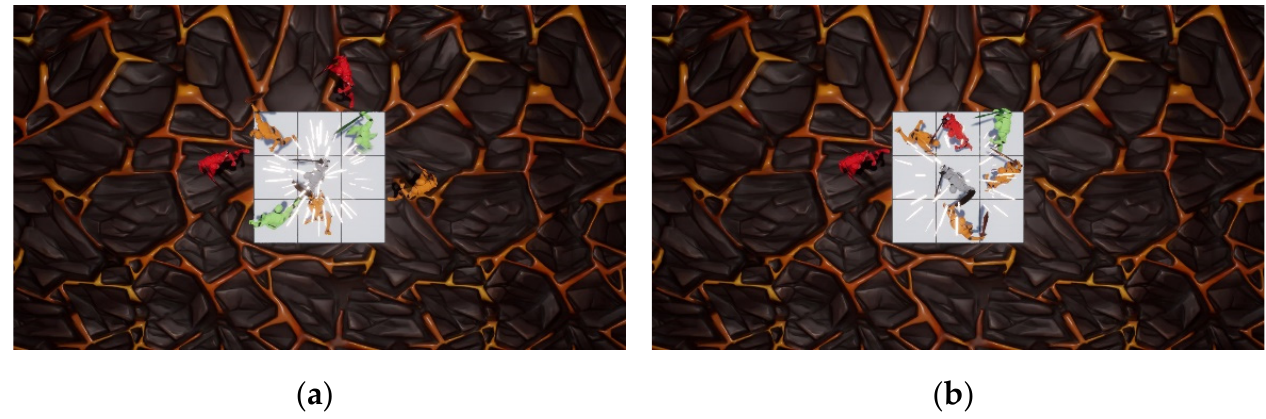
Figure 7. Attack mechanism tests of BAI. ( a ) The first combat scene; ( b ) The second combat scene.